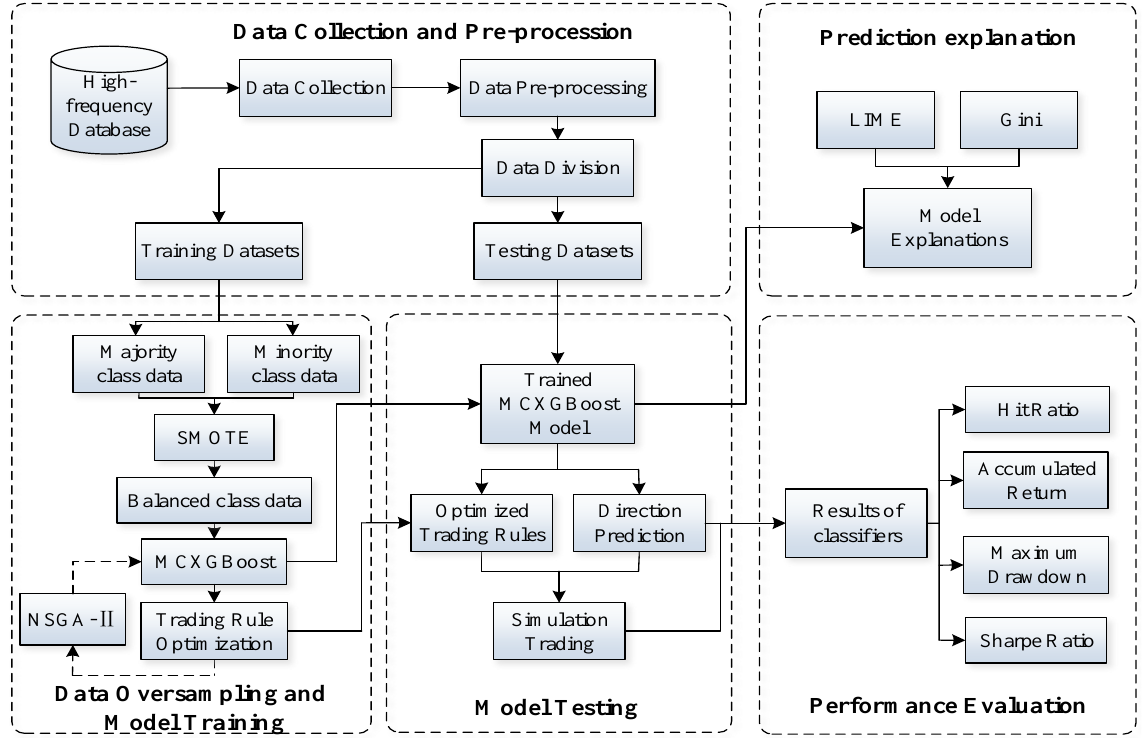
Figure 1. The structure of the proposed approach XGBoost-SMOTE-NSGA-II.